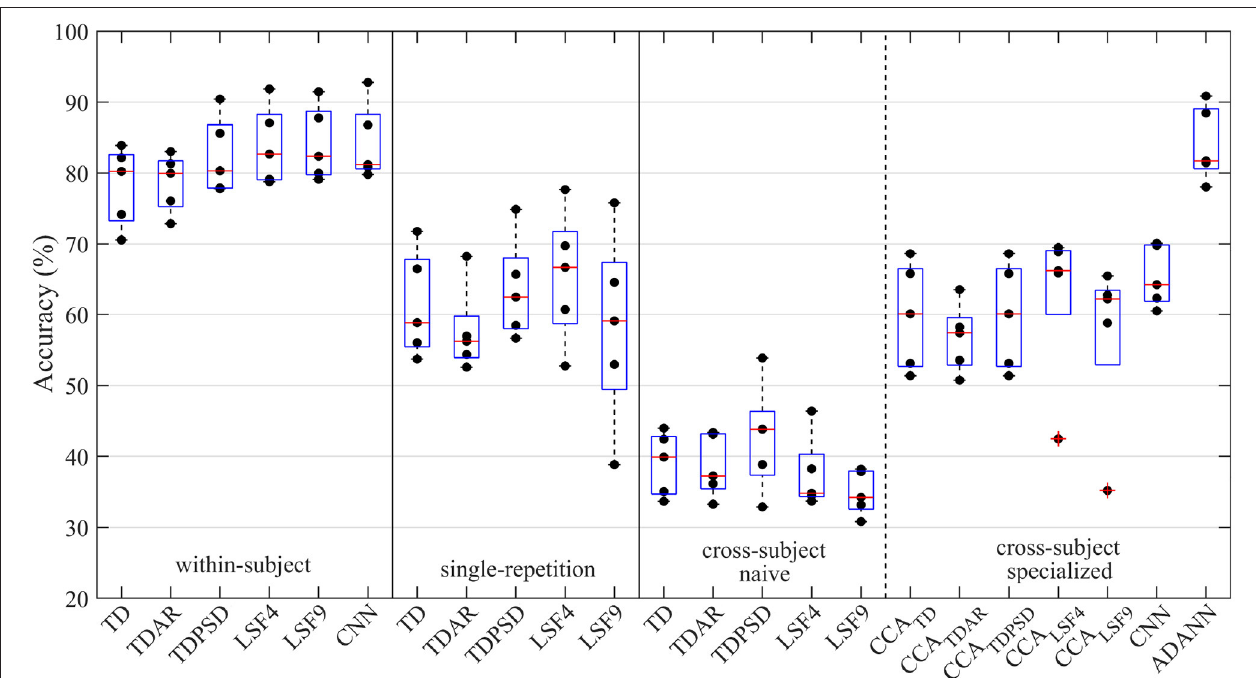
FIGURE 3 | Accuracy of the amputee gesture recognition pipelines explored throughout the study. The pipelines were categorized according to their evaluation framework: within-subject, single-repetition, or cross-subject. The cross-subject framework was further divided into naive cross-subject pipelines and specialized cross-subject pipelines. These signified the absence or presence of a cross-subject specific solution leveraged to minimize the accuracy degradation due to between-subject variance, respectively. A dot represents the average accuracy across all gestures for an amputee subject using a particular gesture recognition pipeline; whereas the boxplot represents the distribution of accuracies among amputee